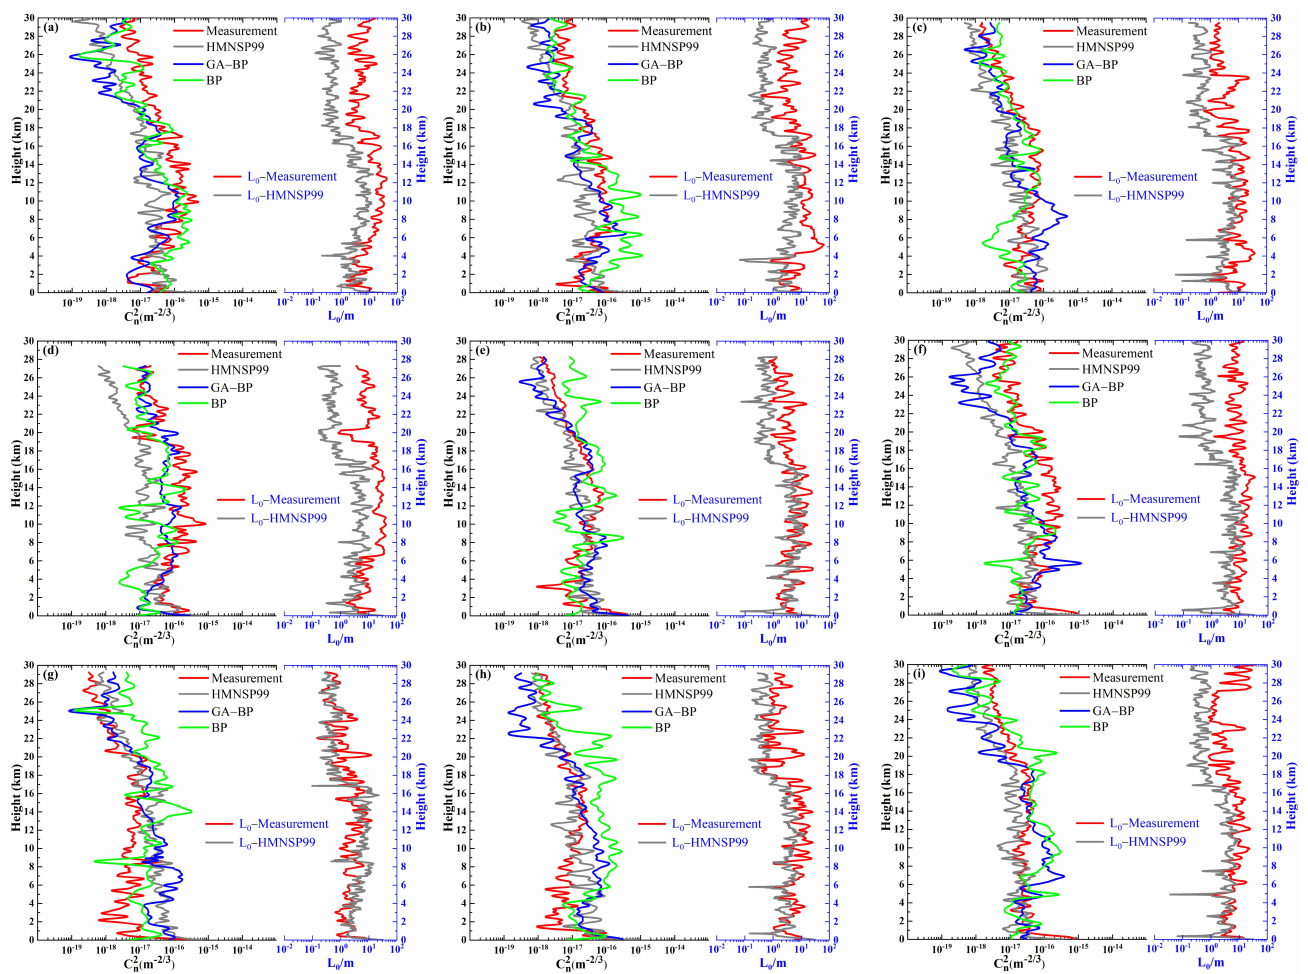
Figure 7. ( a – i ) Comparison of the C 2 n ( h ) profiles (left) between the models (GA-BP, BP and HMNSP99) and the measurement, the L 0 ( h ) profiles (right) from the HMNSP99 model and the measurement in the